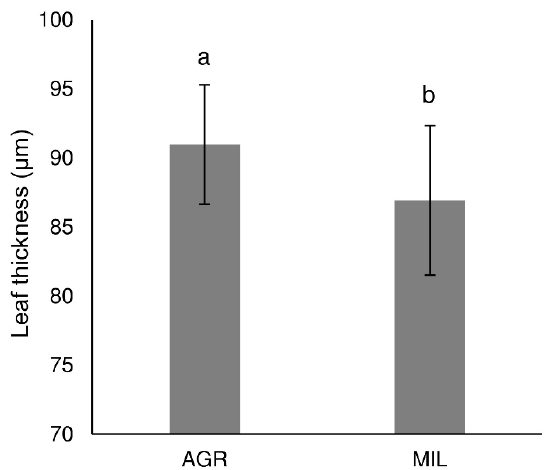
Figure 6. Leaf thickness in section taken 1 cm from leaf tip (mean ± SD, n = 24), the same letters above bars mark comparable groups according to T-test ( p < 0.05)